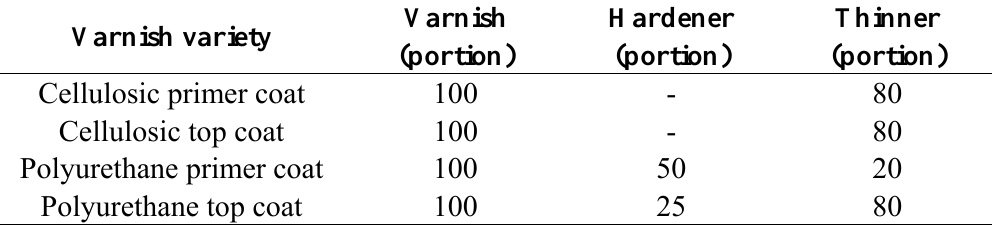
Table 2. Mixture portion of